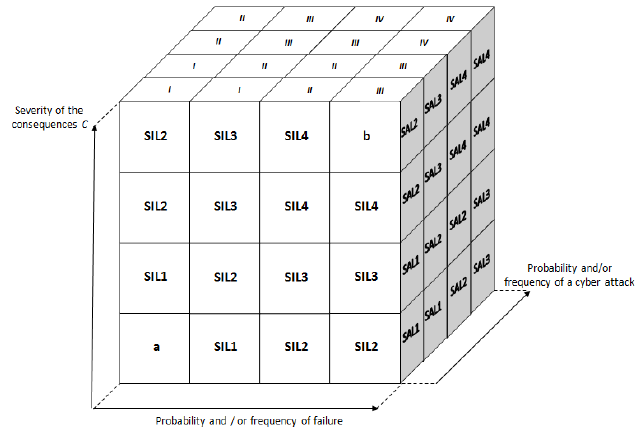
Figure 4. Risk Cube (SIL-SAL).